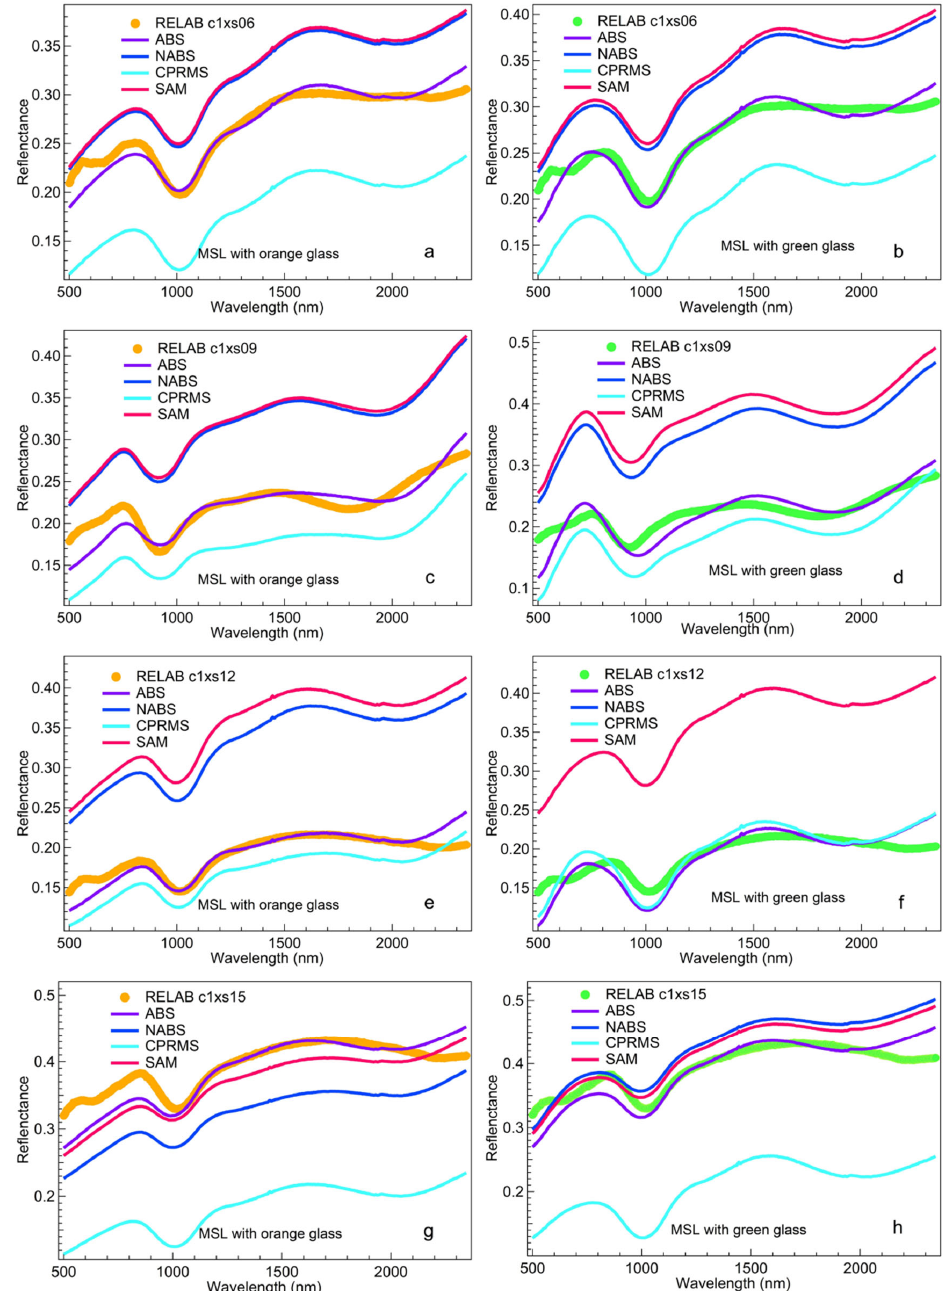
Figure 6. Comparisons of RELAB sample spectra with the corresponding best-matched MSL spectra (green or orange glass) were obtained using four different fitting metrics (Equations (15)–(18)). The results shown in ( a , c , e , g ) and those in ( b , d , f , h ) are obtained using the MSL with orange and green glasses, respectively. c1xs06, c1xs09, c1xs12, and c1xs15 are spectra ID corresponding to RELAB sample ID XS-JFM-006, XS-JFM-009, XS-JFM-012, and XS-JFM-006,